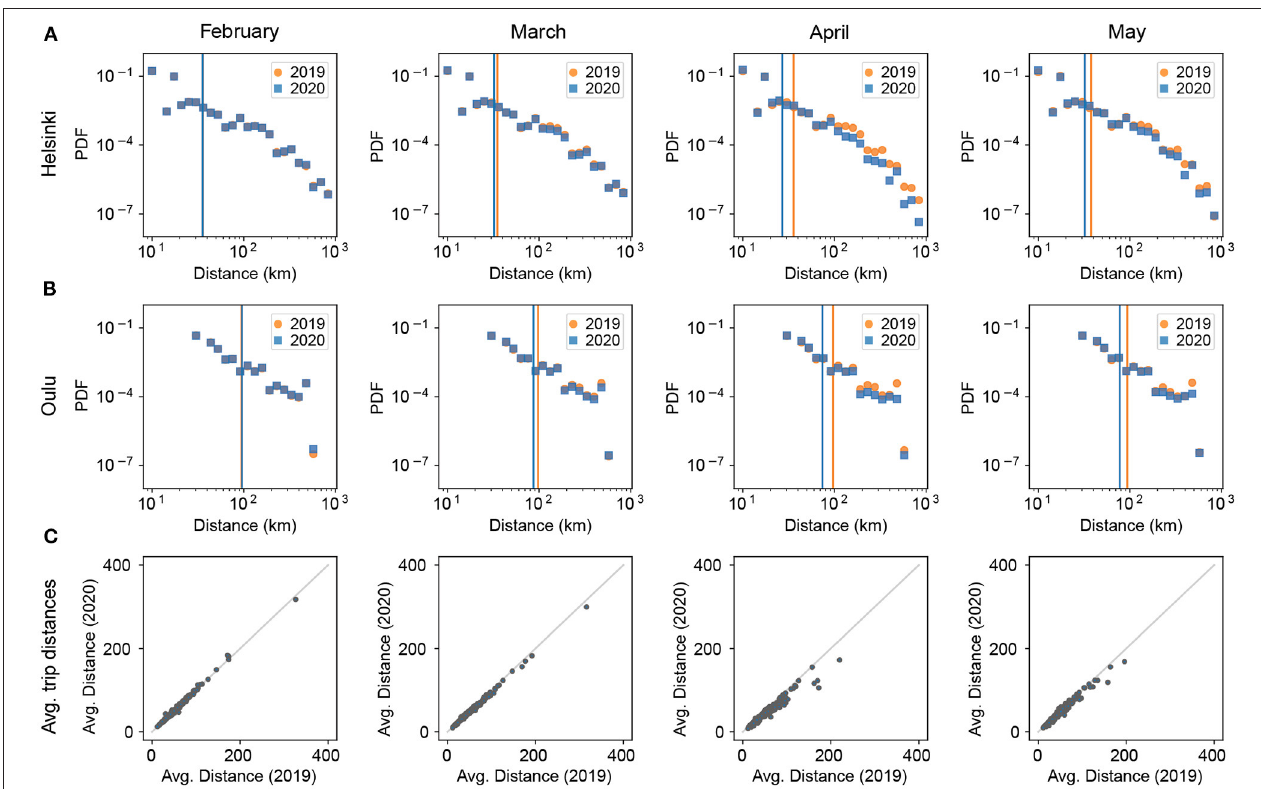
FIGURE 5 | Mobility changes in Finland in terms of travel distance during 2020. (A) The distance distribution of outgoing trips for Helsinki; (B) The same distribution for Oulu. The greatest reduction occurs for long-distance trips. The vertical lines indicate the average outgoing trip distance for each period (orange: 2019, blue: 2020). (C) Scatterplot of the average outgoing trip distances for all cities for 2019 and